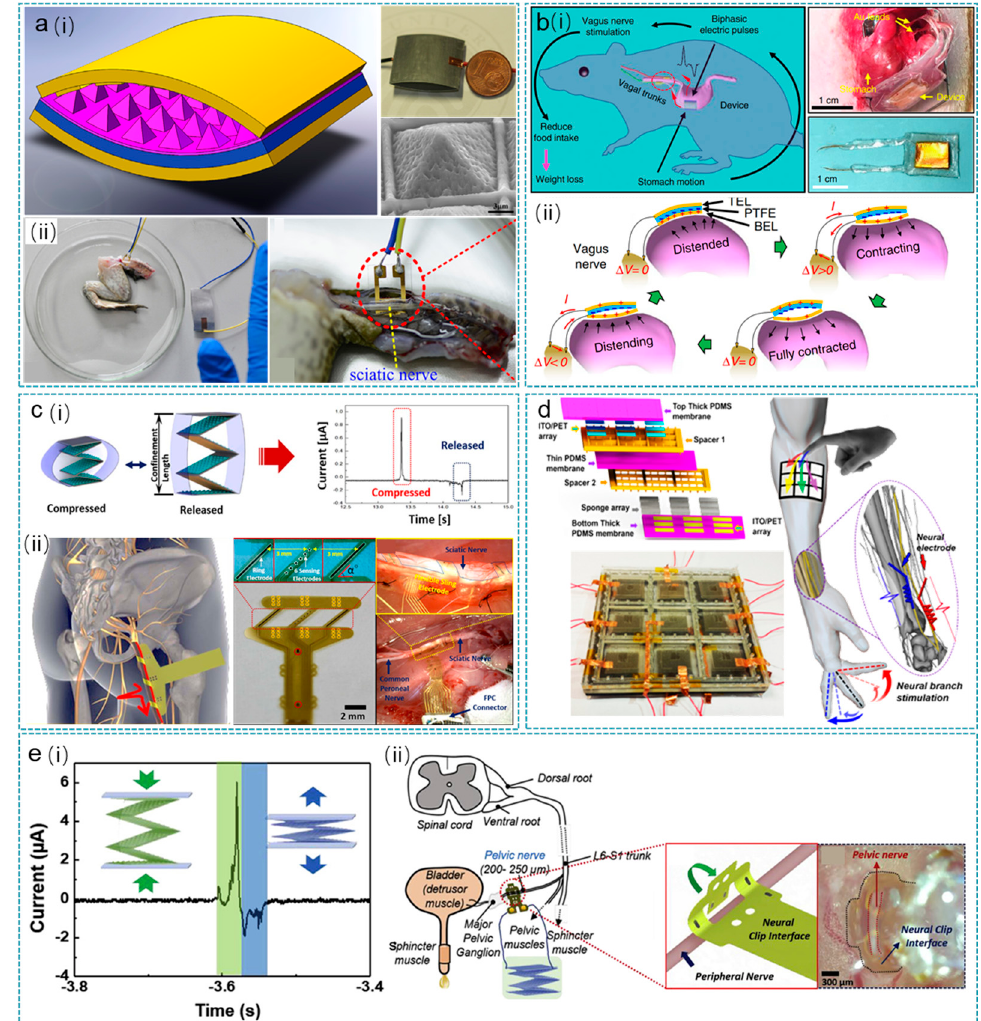
Figure 6. TENGs for nerve stimulation. ( a ) High-performance TENG for frog sciatic nerve stimulation. (i) The structure diagram and image of the high-performance TENG. (ii) The high performance TENG for frog sciatic nerve stimulation. Reprinted with permission from Ref. [169]. Copyright 2014 Elsevier. ( b ) Effective weight control via nerve stimulation (VNS). The schematic diagram of VNS system (i) and the working principle of VNS devices (ii). Reprinted from Ref. [109]. Copyright 2018